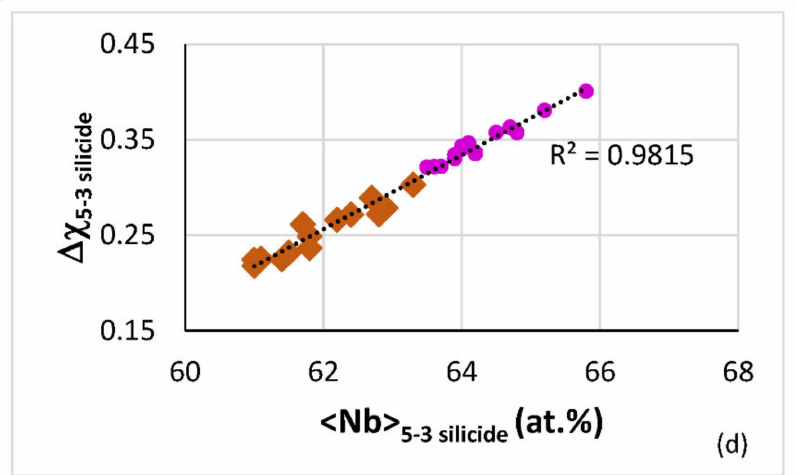
Figure 5. Maps of the 5-3 silicide in the AC and HT boron-containing alloys TT2, TT3, TT4 and TT8, i.e., of the T2 silicide, and the reference B-free alloys KZ4, KZ5, KZ7 and JG3, i.e., of Nb 5 Si 3 . ( a ) and ( b ) ∆ χ versus VEC, ( c ) VEC versus <Nb> and ( d ) ∆ χ versus <Nb>. Diamonds for B-containing alloys, i.e., data for T2, and pink filed circles for the B free alloys, i.e., data for Nb 5 Si 3 . ( a ) and ( d ) data for T2, Ti-rich T2, Nb 5 Si 3 and Ti-rich Nb 5 Si 3 . ( b ) and ( c ) data for T2 and Nb 5 Si 3 in the aforementioned alloys. In ( b ) and ( c ) green for TT2 and KZ4, red for TT3 and KZ7, purple for TT4 and KZ5, and blue for TT8 and JG3. <Nb> means Nb and other elements that substitute Nb in silicide. For all data in ( a ) R 2 = 0.5173 for linear fit. The dashed lines in ( a ) delineate the “territory” occupied by the T2 silicide in the B containing alloys TT2, TT3, TT4 and TT8 (defined by ∆ χ and VEC approximately less than 0.303 and